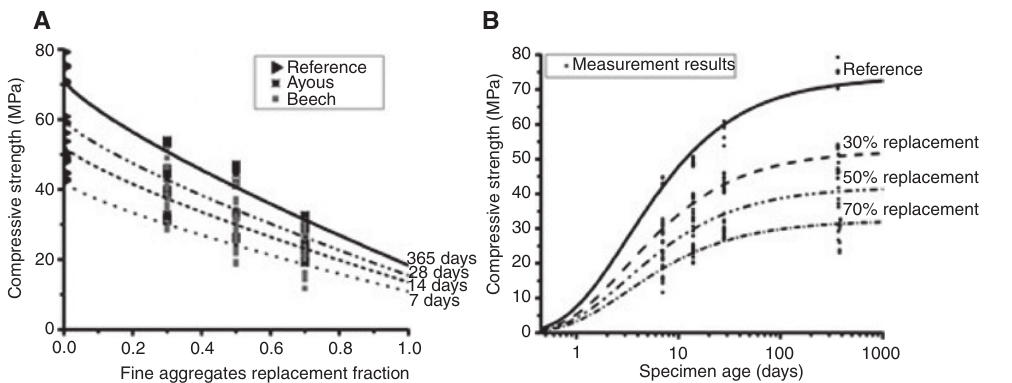
Figure 7: (A) Compressive strength versus fine aggregates replacement fraction, (B) compressive strength versus specimen